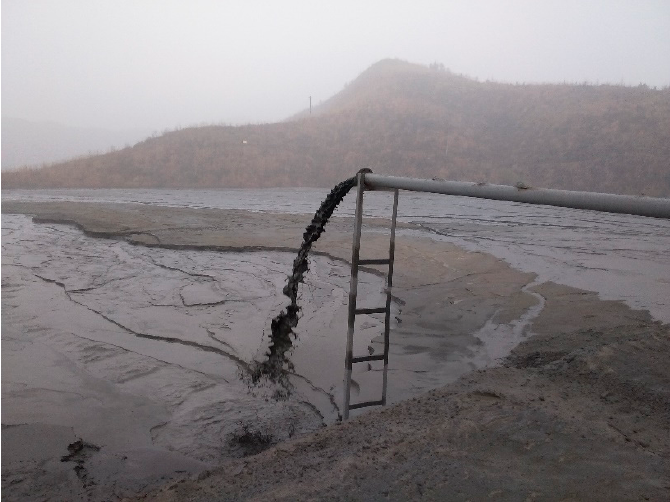
Figure 4. Actual flow rate of tailings slurry at the discharge outlet.